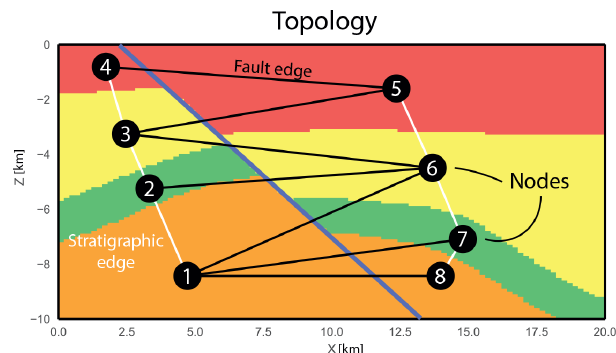
Figure 7. Section of the example geomodel with overlaid topology graph. The geomodel contains eight unique regions (graph nodes) and 13 unique connections (graph edges). White edges represent stratigraphic and unconformity connections, while black edges cor- respond to across-fault